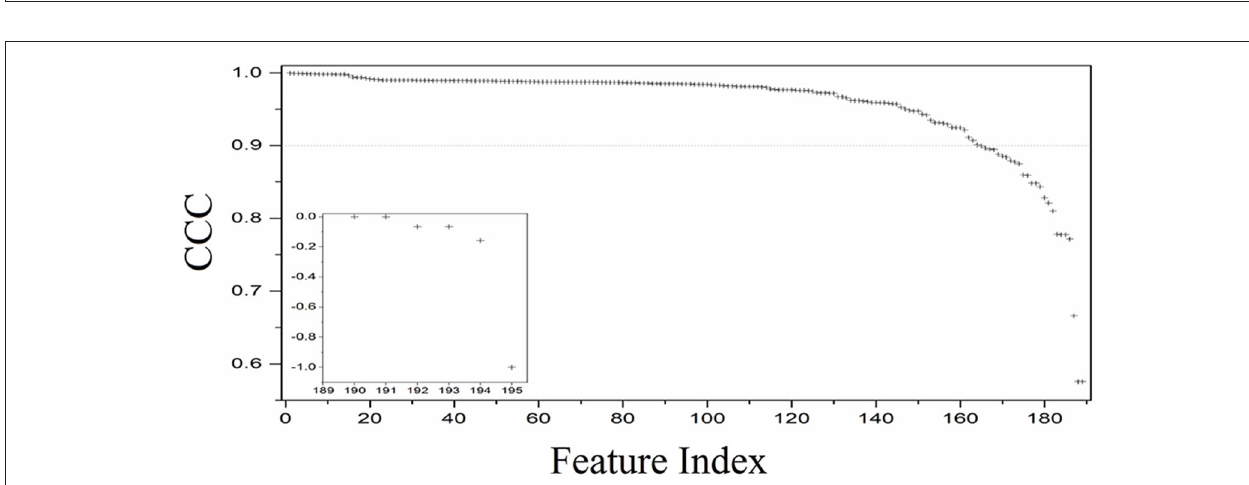
FIGURE 3 | The MVCT images of wood surrounded by different kinds of scatter materials: (A) no scatter, (B) 5cm of rice, and (C) 5cm of sand.